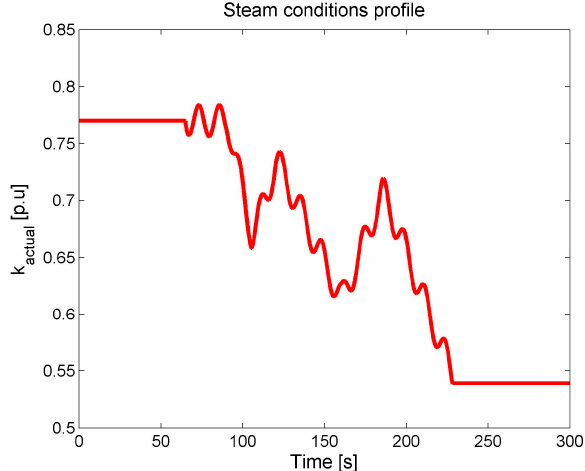
Figure 20. Unexpected steam conditions profile.